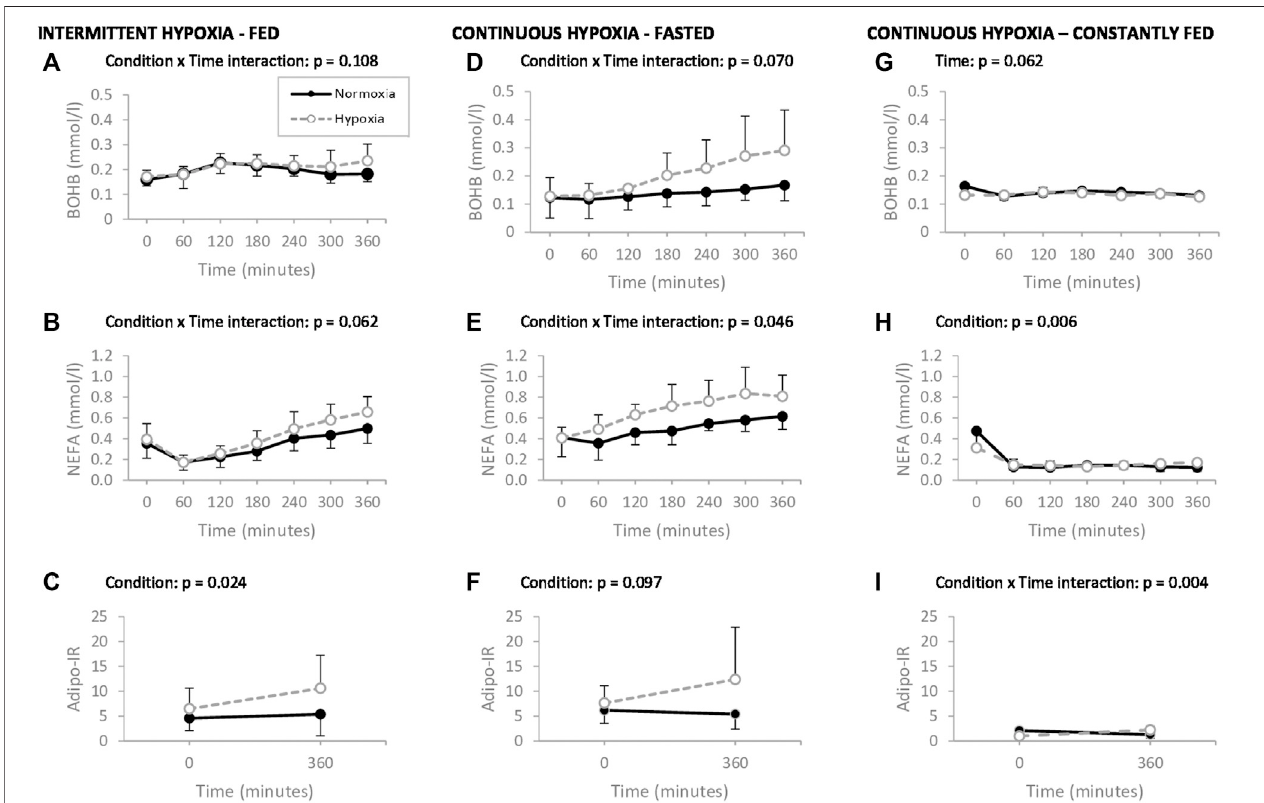
FIGURE 2 | Plasma ß-hydroxybutyrate (ßOHB), nonesteri fi ed fatty acids (NEFA) and adipose tissue insulin resistance index (Adipo-IR), measured during 6 h of normoxia ( – . – ) or intermittent hypoxia (--o--) following an isocaloric high fat meal (A – C) , during 6 h of normoxia ( – . – ) or continuous hypoxia (--o--) under faster stat (D – F) andduring6 hofnormoxia( – . – )orcontinuoushypoxia(--o--)inaconstantlyfedstat (G – I) ,inhealthymen. p valuesexcludetime0inIH-FedandCH-Fedtrials.Valuesare means ± standard